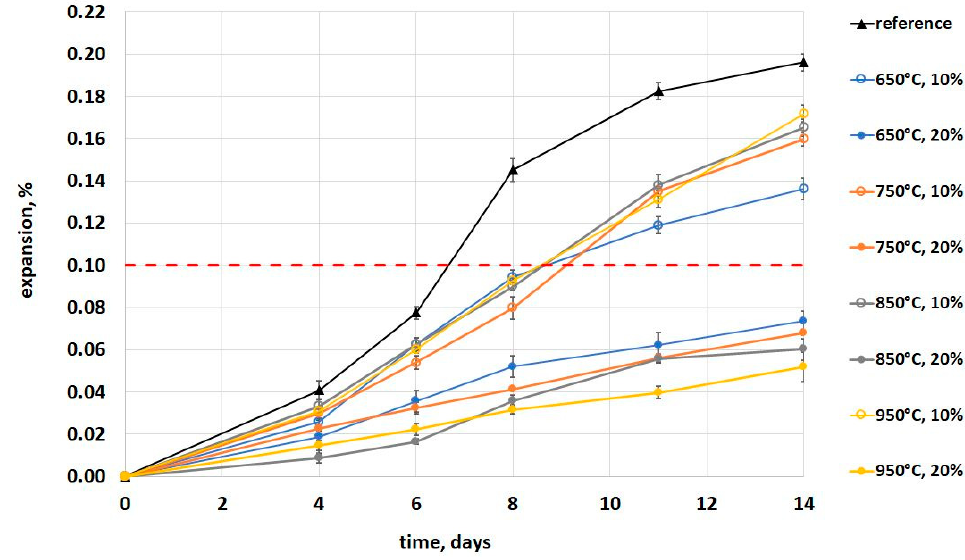
Figure 5. Results of the mortar bars expansion stored in 1N NaOH and at 80 °C.